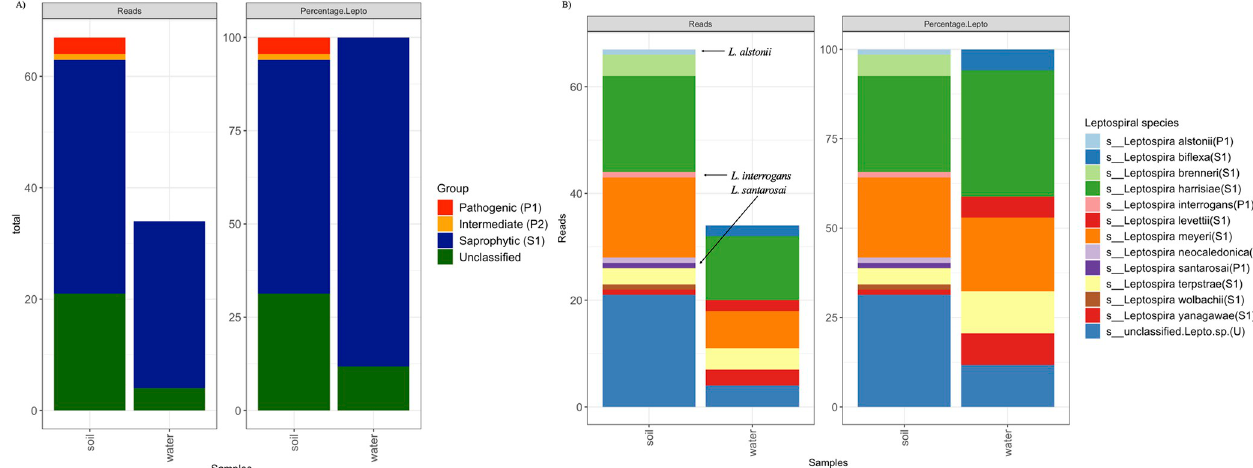
Fig 2. Leptospira composition profiles for directly sequenced soil and water samples. 2A. Proportion of Leptospira clades identified; 2B. Leptospira species- level classification. P1 clade species identified in the soil sample is labeled in the figure. The clade of each Leptospira species is annotated in the parenthesis behind species names in the figure legend (P1: Pathogenic; P2: Intermediate; S1: Saprophytic clade 1; U: Unclassified).